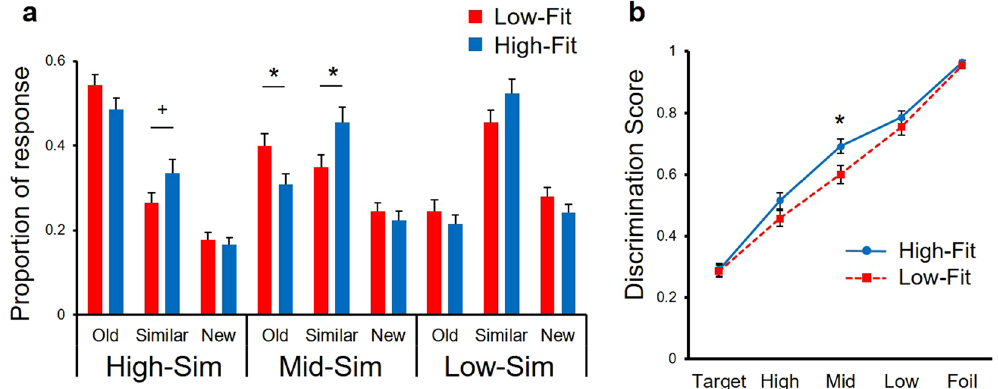
Figure 2. ( a ) Response proportions for each category of high-, middle- and low-similarity lures in High-Fit and Low-Fit groups. Note that response types (old, similar, new) are not independent categories. Values are mean ± SE, * p < 0.05, + p < 0.1. ( b ) Mnemonic discrimination performance differences between High-Fit and Low-Fit as a function of interference levels. Discrimination score = 1 − p(“old”|Type). Values are mean ± SE, * p < 0.05.